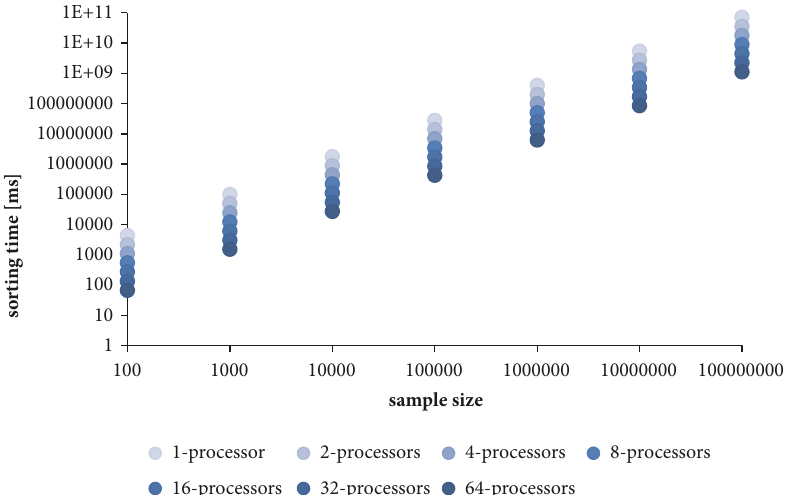
Figure 9: Chart of the theoretical complexity for the proposed method showing the potential growth in efficiency of the proposed approach for multicore architectures up to 64